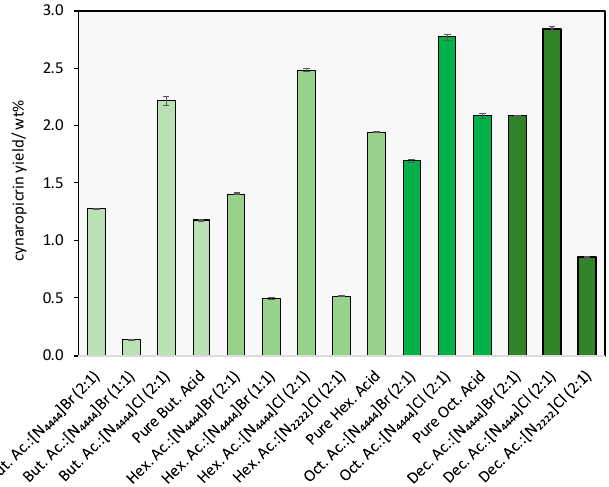
Figure 2. Cynaropicrin extraction yield from C. cardunculus leaves using several DES at different molar ratios (HBD:HBA) and the corresponding pure acids; T = 25 °C, t = 120 min and S/L ratio = 1.10. The results presented correspond to the average of three independent experiments.